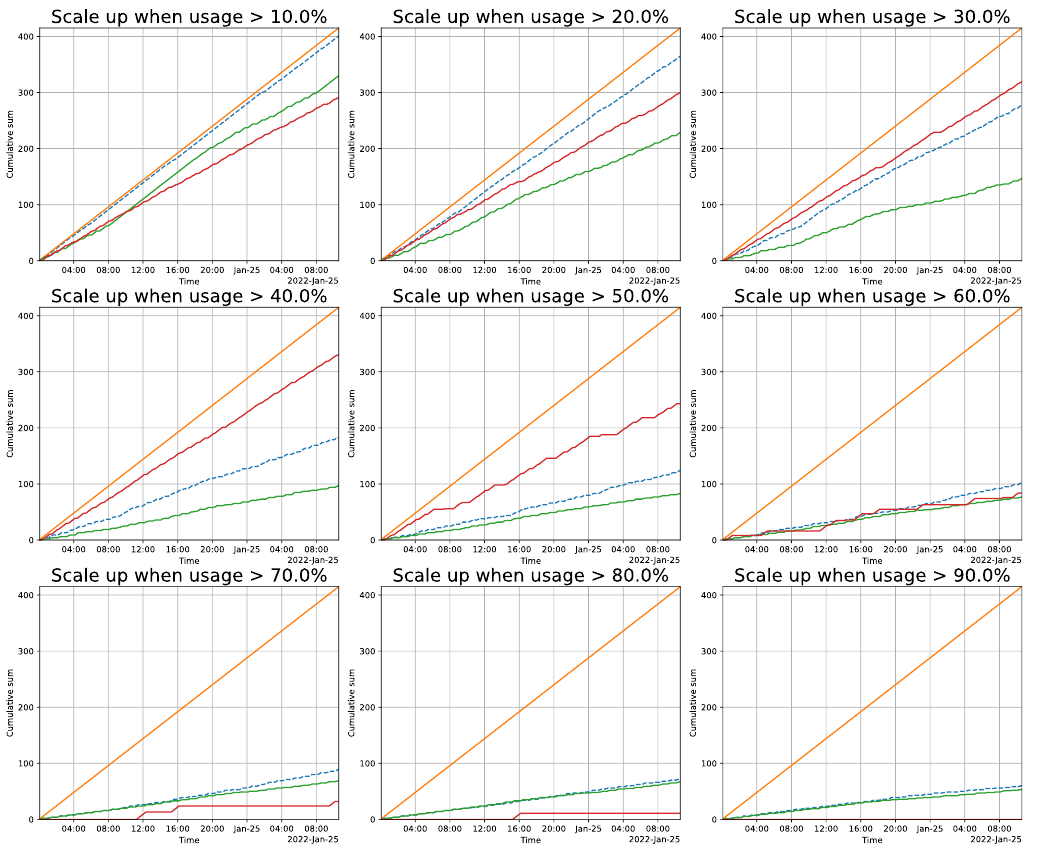
Figure 15. Cumulative sum of resource usage.